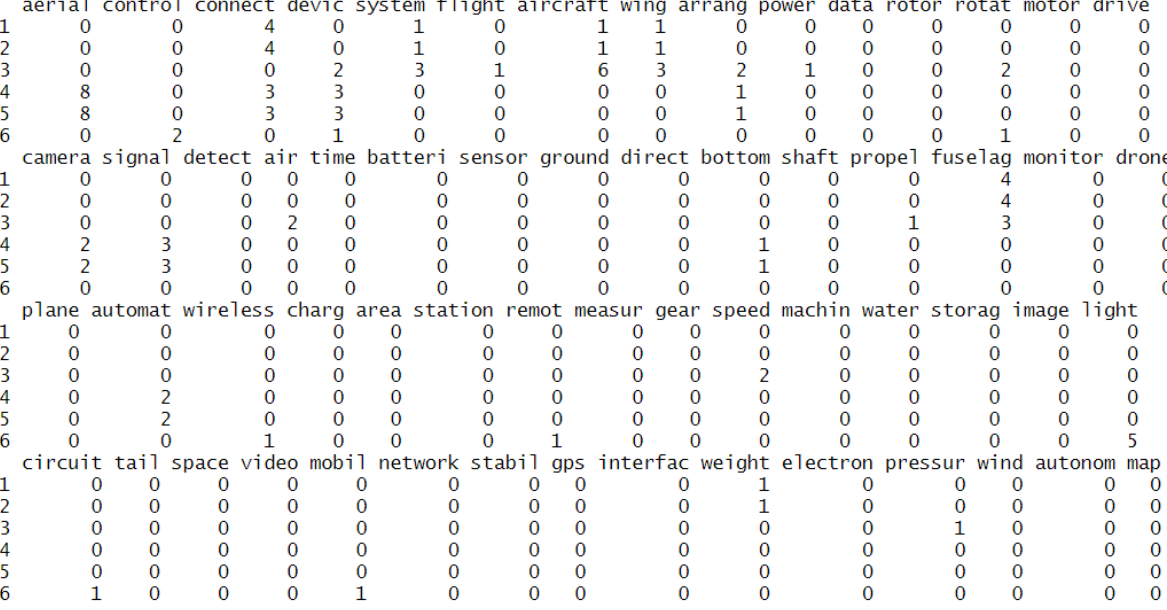
Figure 3. Structured data of drone patent documents.